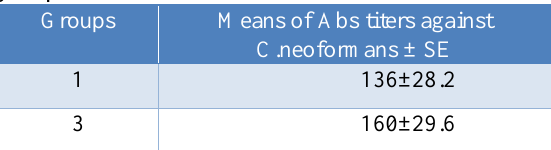
Means of Abs titers against